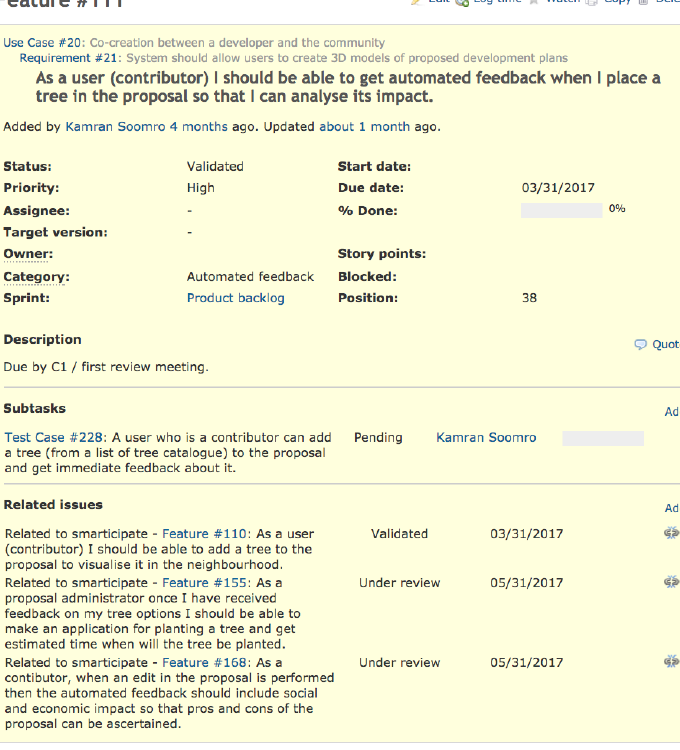
Figure 3. An example of a feature derived from a requirement.